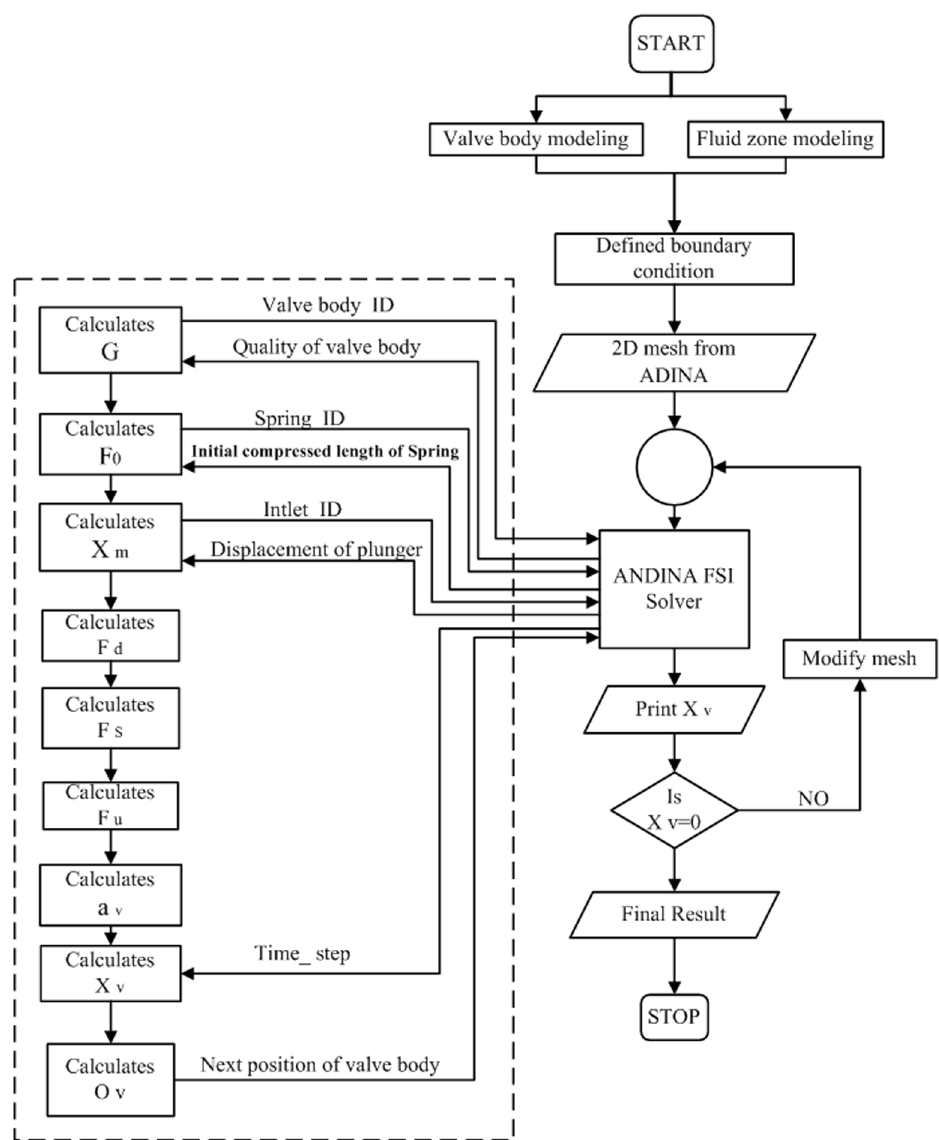
Fig 8. Flow chart of valve motion analysis of a reciprocating